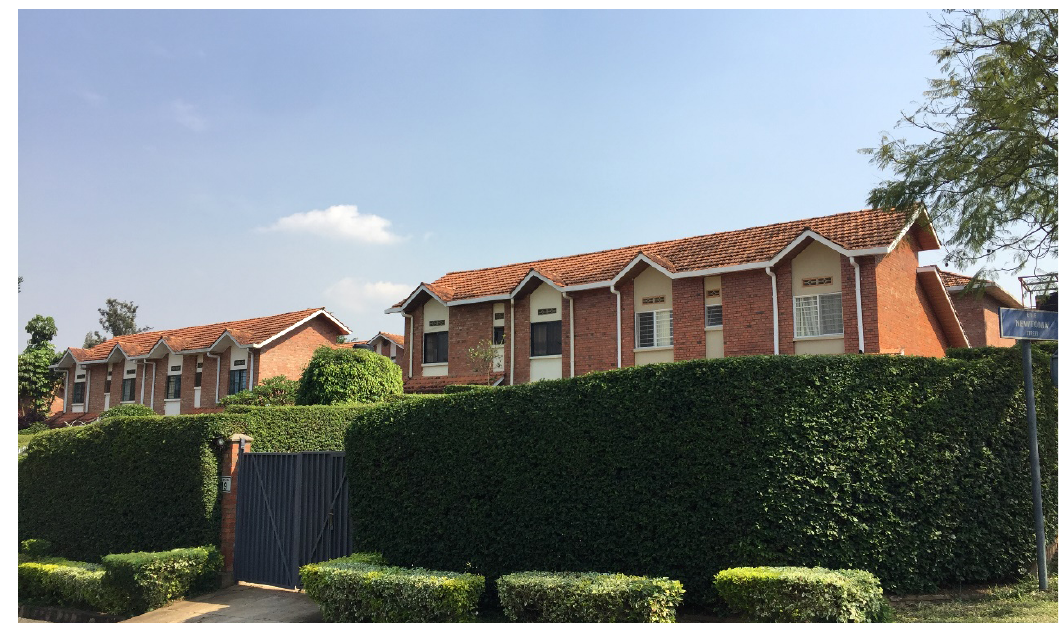
Figure 40. Twin House Type 2: Front yard. Photograph by Manlio Michieletto.